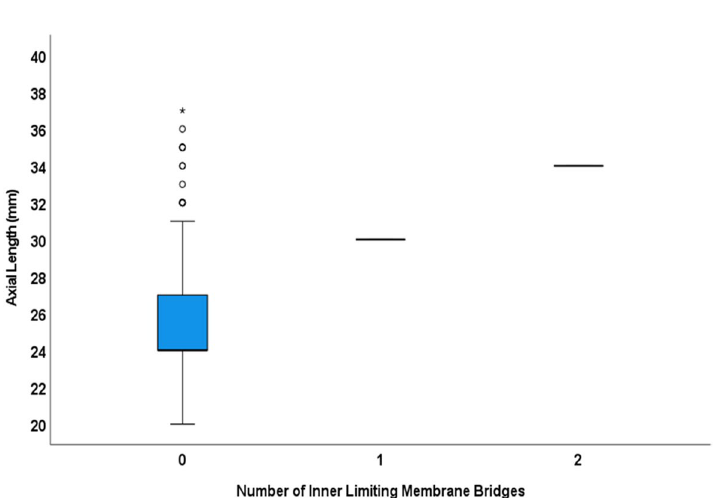
Figure 5. Boxplot showing the distribution of the number of inner limiting membrane bridges and axial